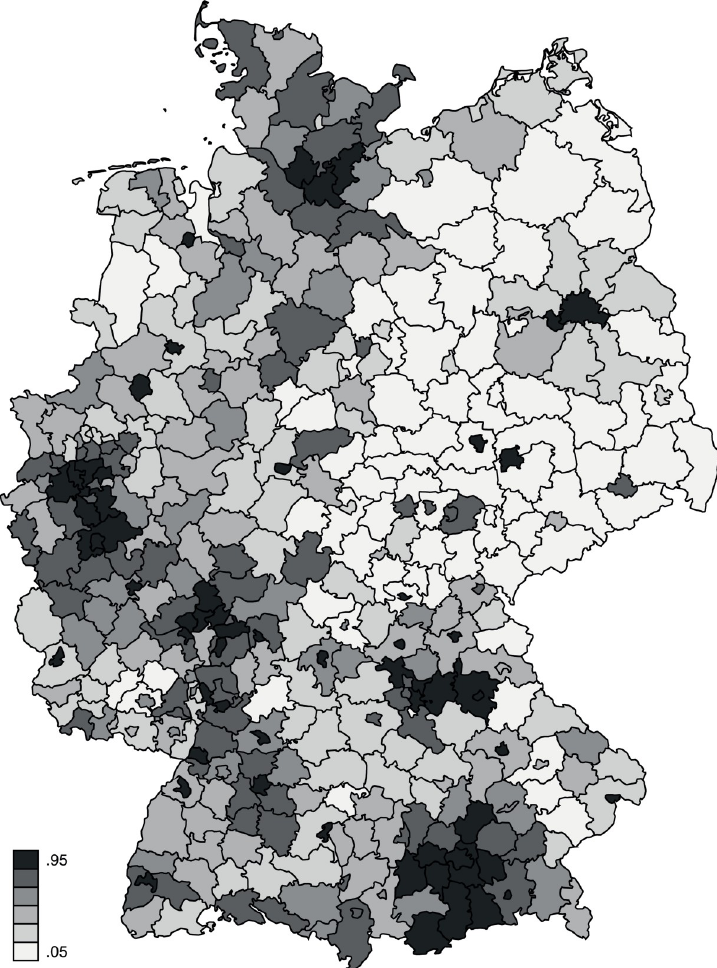
Fig 2. Regional distribution of digital culture,.de-domains per capita 2012 [74]. (A) © GeoBasis-DE/BKG (2011).